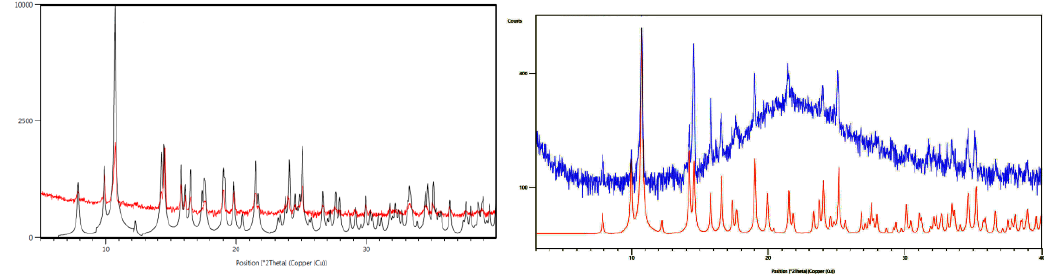
Figure 2. X-ray powder diffraction for: ( left ) DyH 2 daps (red) and simulation from single X-ray data at 225 K (black); ( right ) ErH 2 daps (blue) and simulation from single X-ray data at 250 K